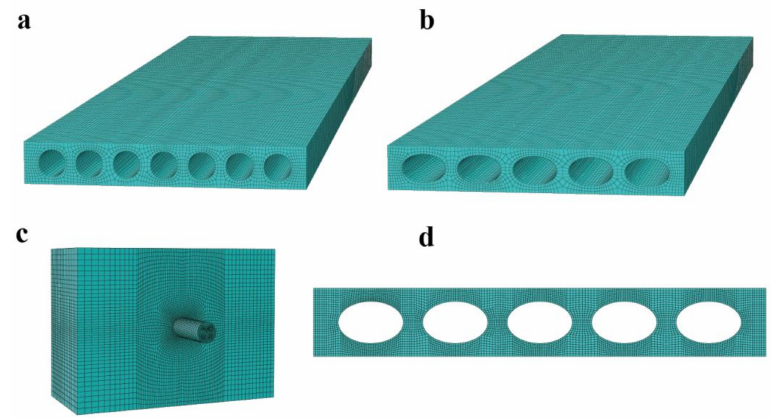
Figure 4. Finite element (FE) models for the partition walls: ( a ) Circular cavity panel in a three-dimensional (3D) view of the FE model; ( b ) Elliptical cavity panel in a 3D view of the FE model; ( c ) FE model of hanging test; and, ( d ) two-dimensional (2D) FE model of thermal